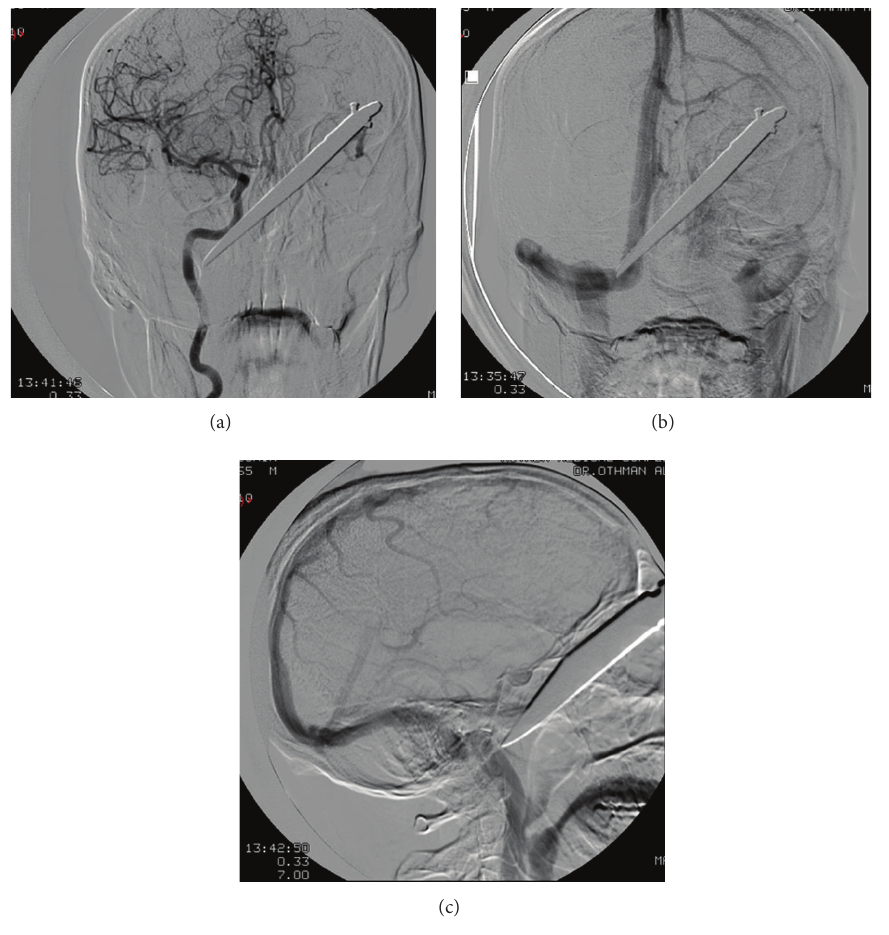
Figure 3: ((a), (b), and (c)) Angiogram to evaluate the integrity of vasculature. The tip of knife is visible near left internal carotid artery. The venous sinus and internal jugular vein appear